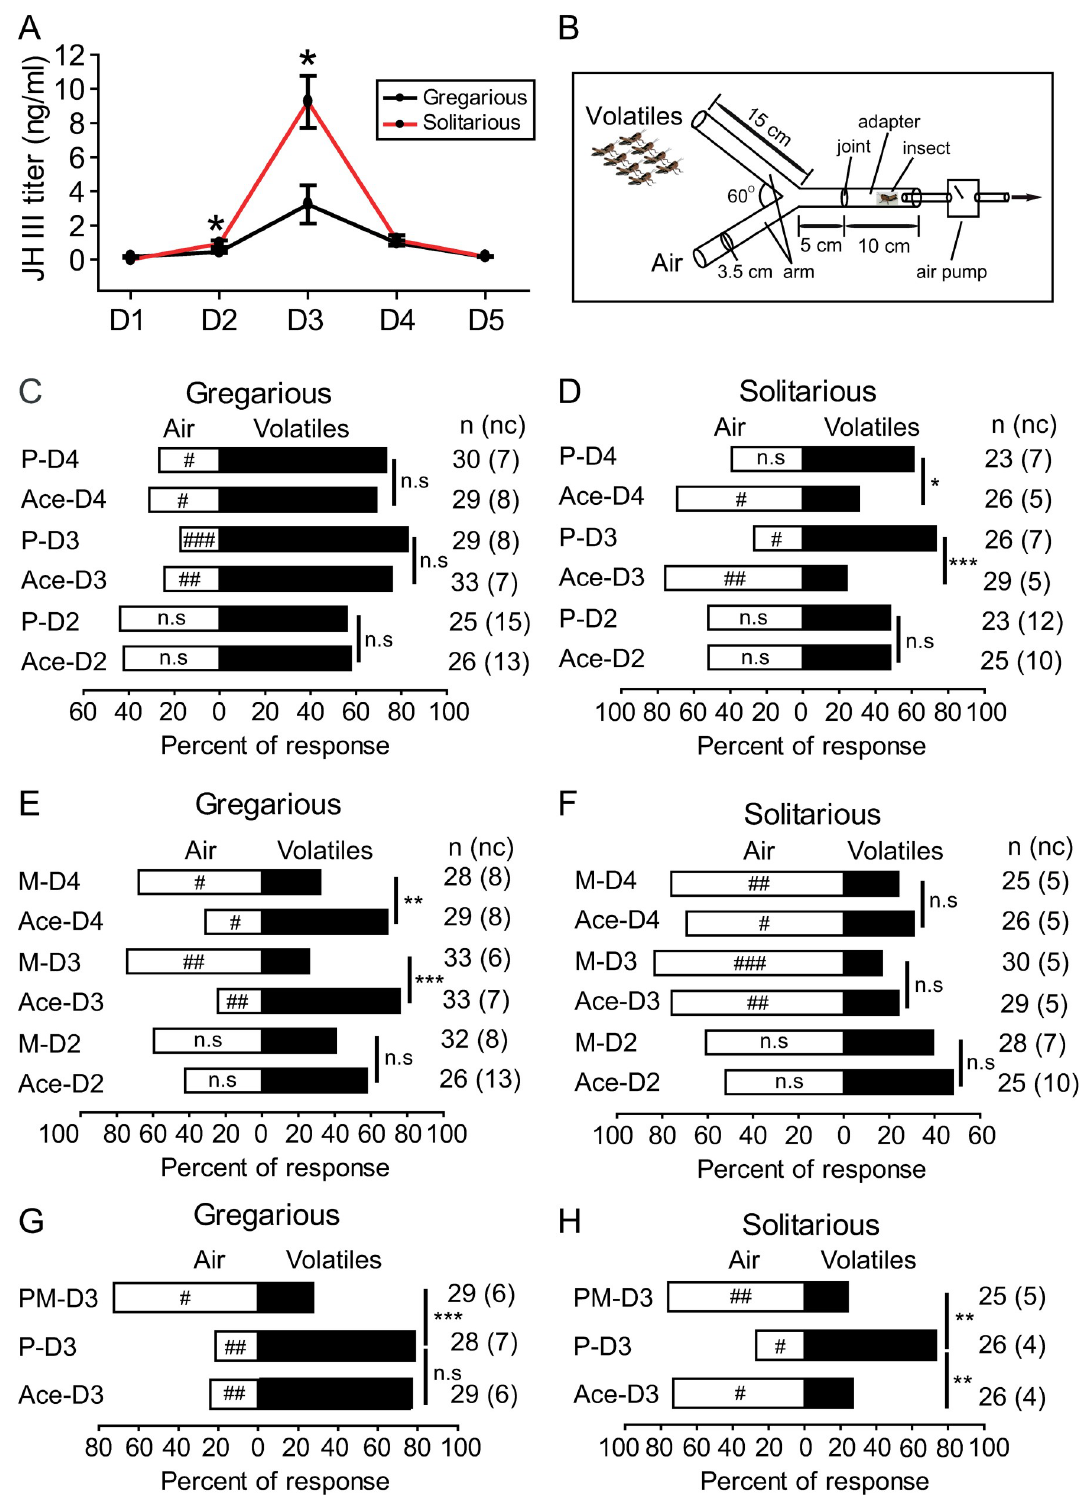
Fig 1. Juvenile hormone titre and its influence on phase-related olfactory behavior in fourth-instar nymphs. (A) JH III titres in hemolymph of gregarious or solitarious nymphs. (B) Schematic diagram of Y-tube olfactometer assay set. Individual nymph was released from Y-tube adapter to observe their choice. (C) Choice behavior of gregarious nymphs at day 2, 3 and 4 (D2,3 and 4) treated